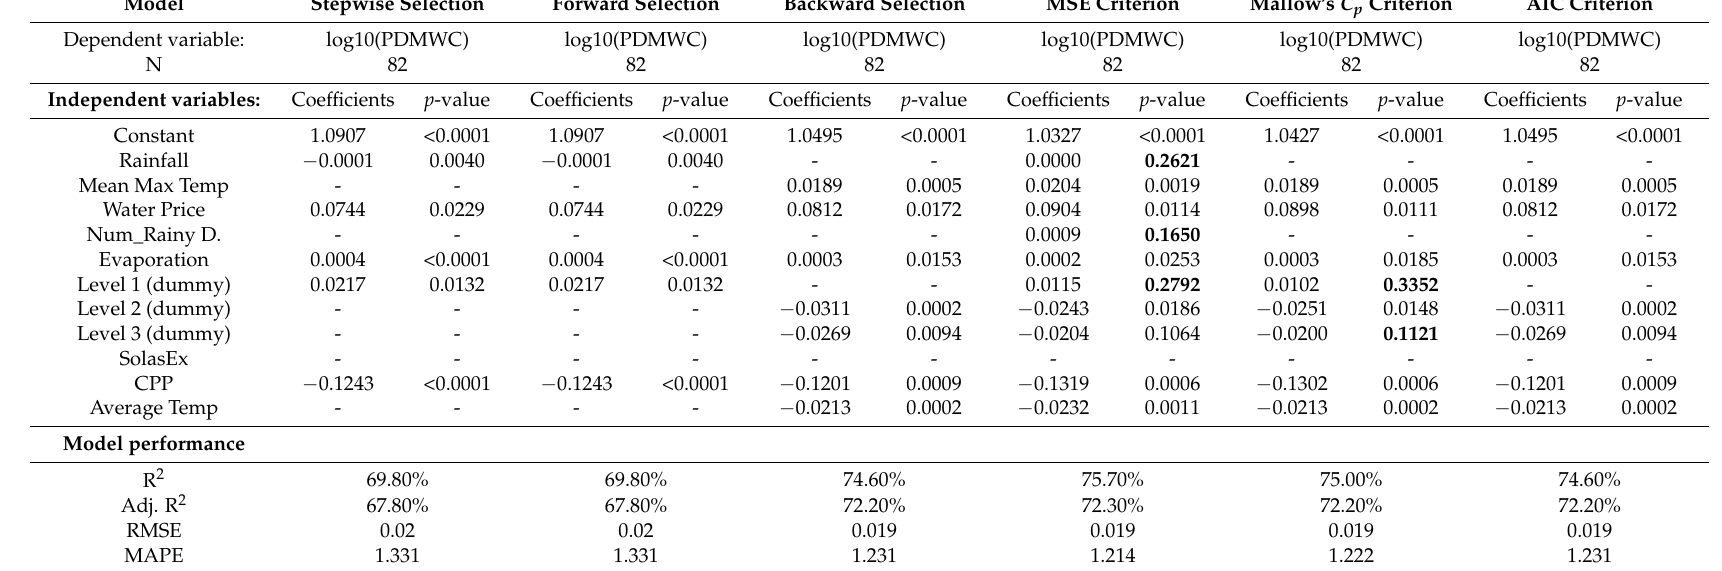
Table 1. Modelling results from the developed models adopting different variable selection methods. CPP, conservation program